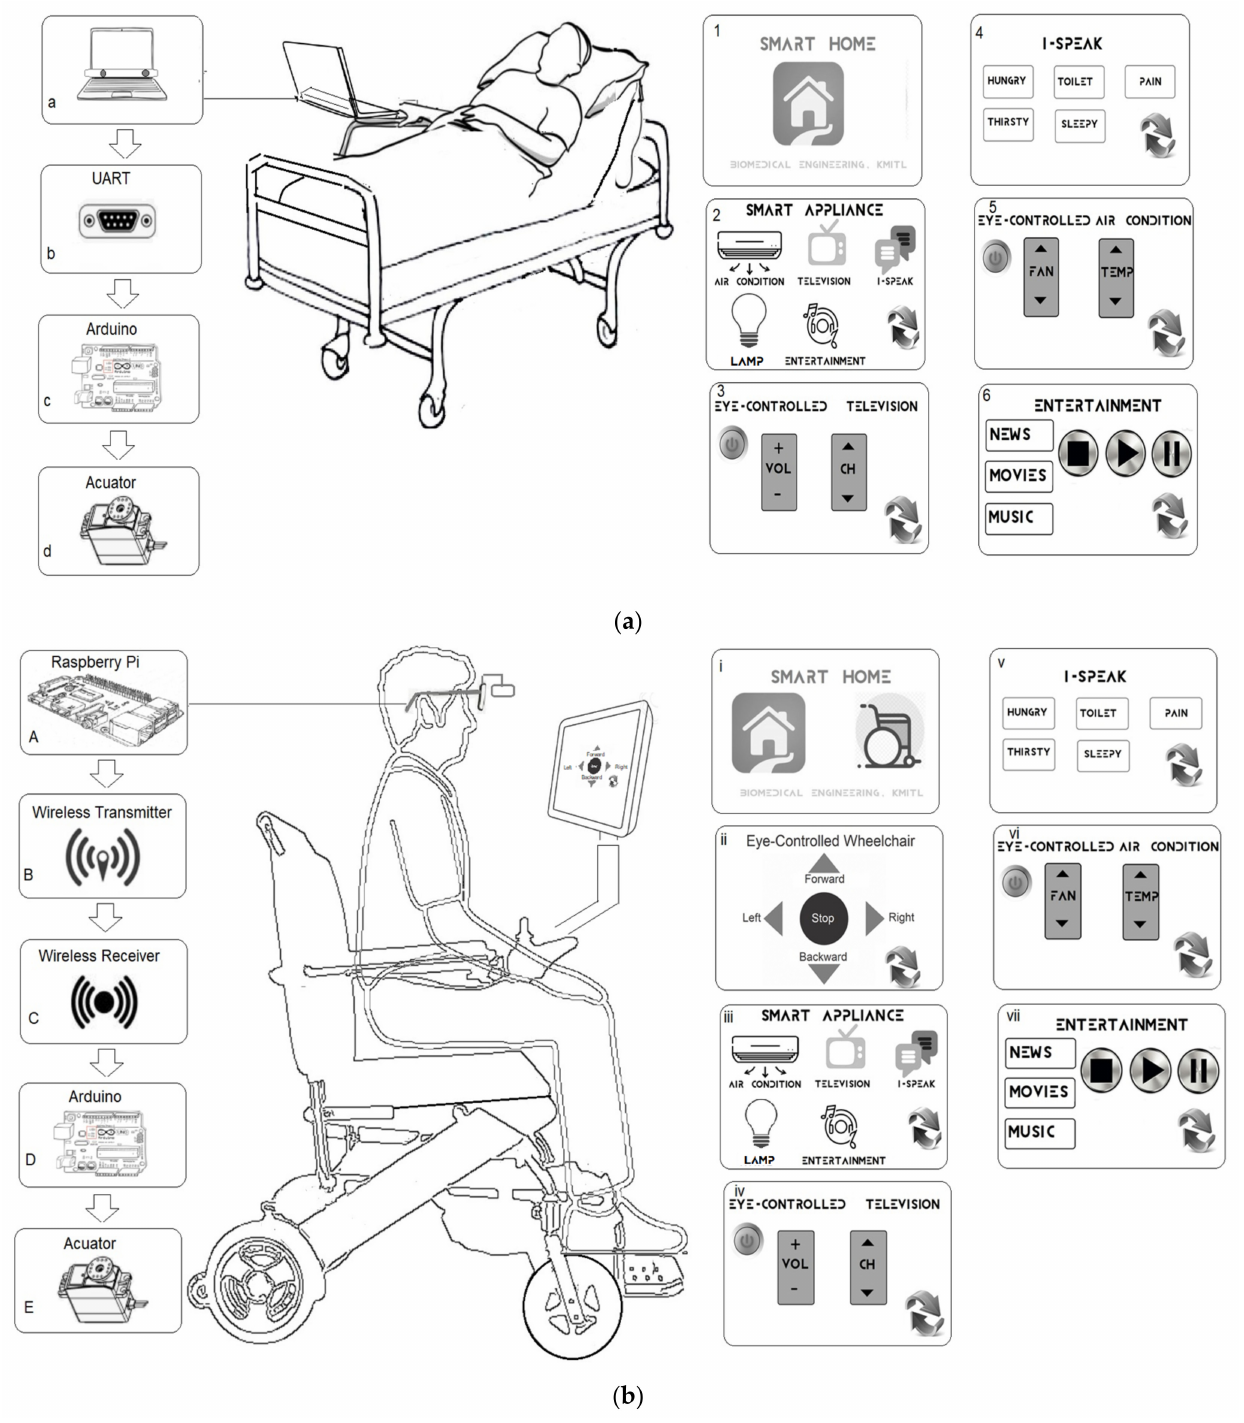
Figure 1. Smart home based on eye tracking: ( a ) stationary system and ( b ) remote